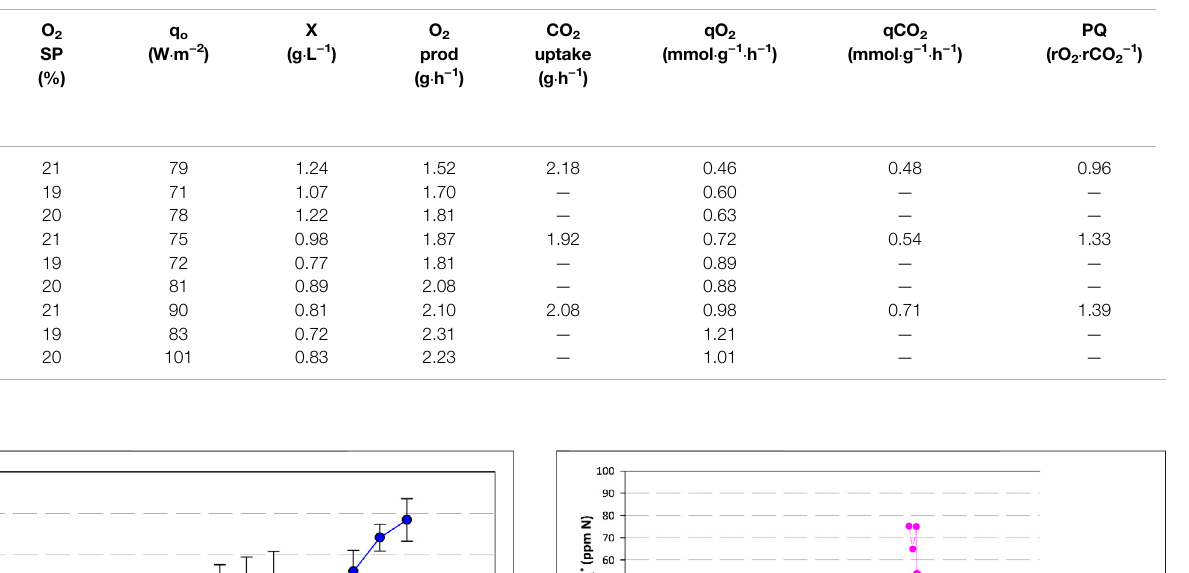
TABLE 3 | PBR performance results in terms of O 2 and CO 2 generation and biomass concentration reached for every condition. CO 2 uptake is only expressed at 21% O 2 set-point as liquid phase is not stable at 19 and 20% leading to variability in TIC concentration.